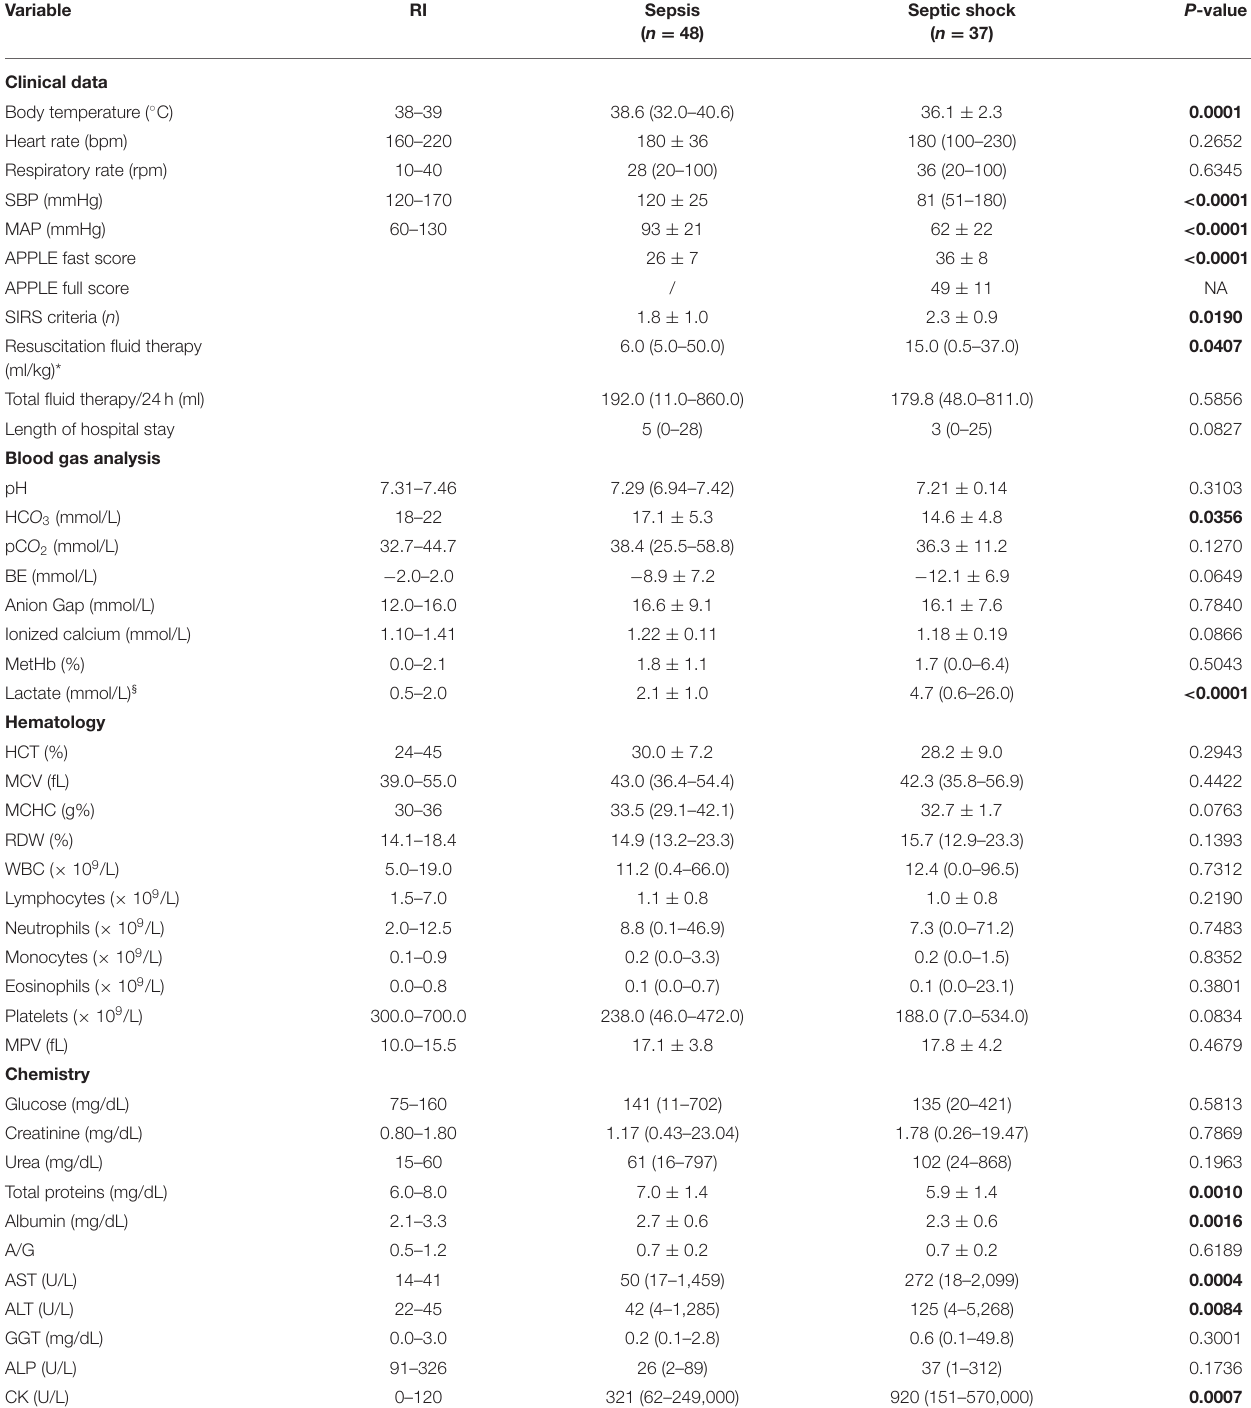
TABLE 2 | Clinical and clinicopathological variables results in cats with sepsis and septic shock.